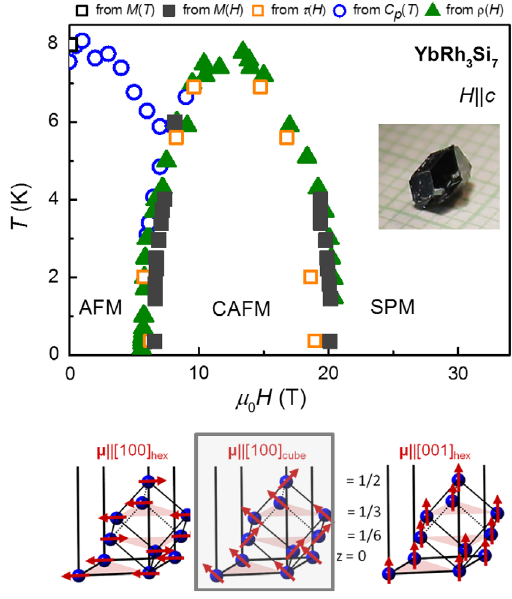
FIG. 4. T − H phase diagram of YbRh 3 Si 7 together with three distinct magnetic spin configurations in different magnetic-field regions. A picture of the crystal is shown in the